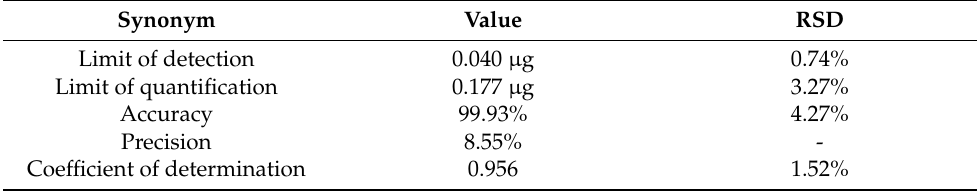
Table 1. Statistical parameters of HPTLC-IS using anti-bovine α -LA antibodies. Synonym Value RSD Limit of detection